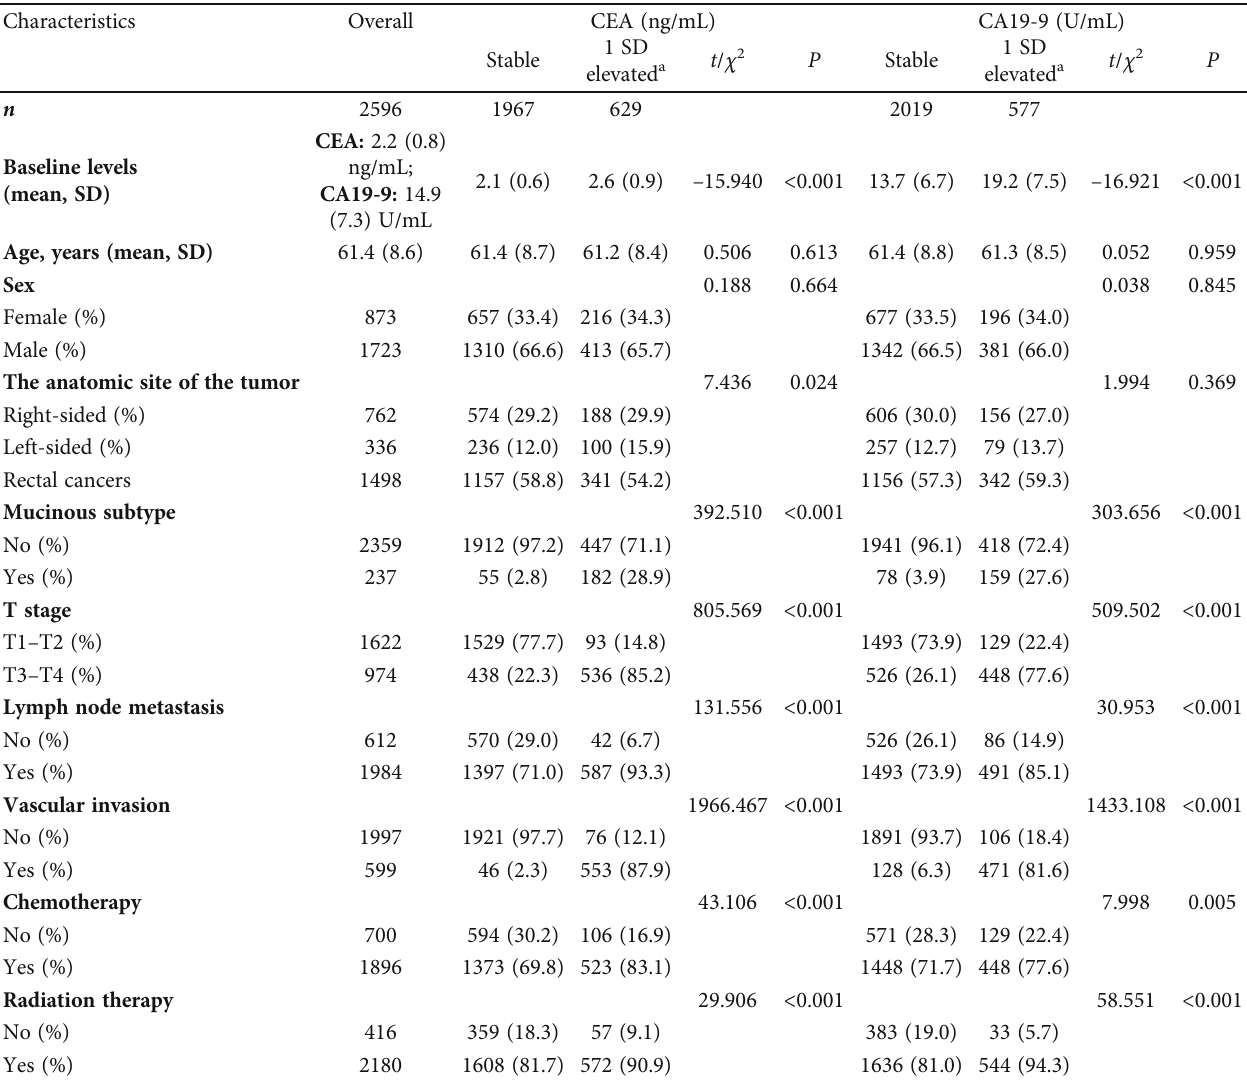
Table 1: Characteristics of study participants.